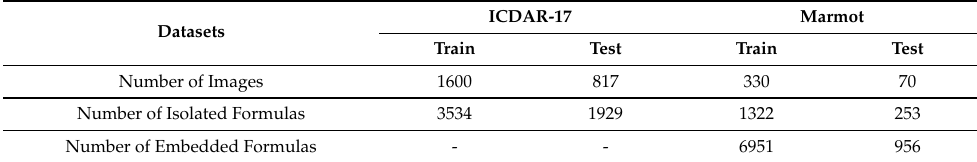
Table 2. Summary of the main statistics of the employed